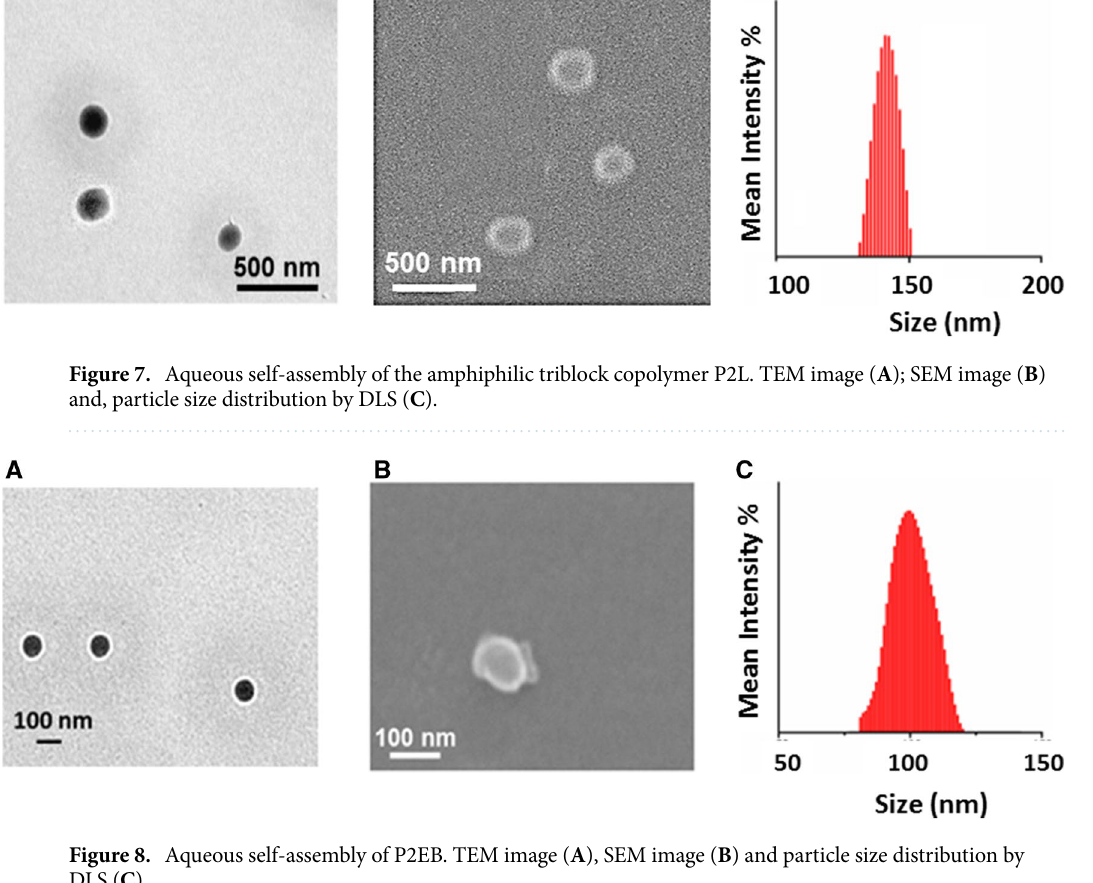
Figure 8. Aqueous self-assembly of P2EB. TEM image ( A ), SEM image ( B ) and particle size distribution by DLS ( C